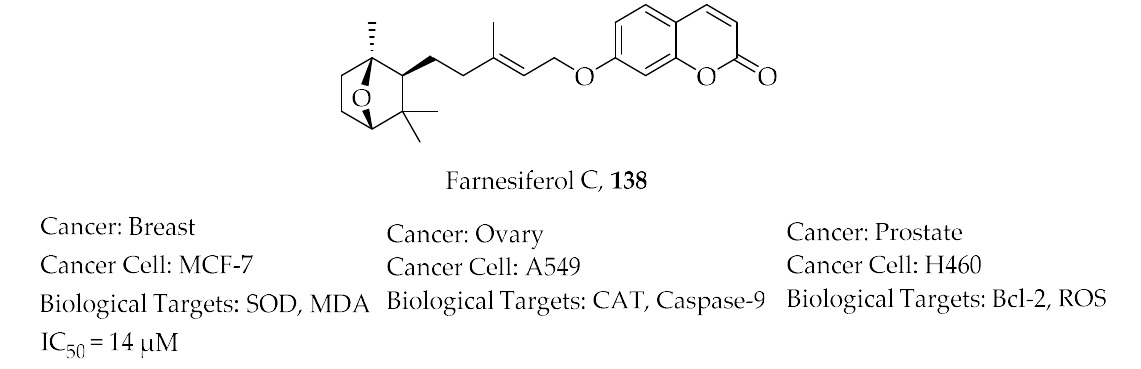
Figure 28. Structure of the sesquiterpene lactone Thapsigargin with a summary of its biological activity towards selected cancer targets.